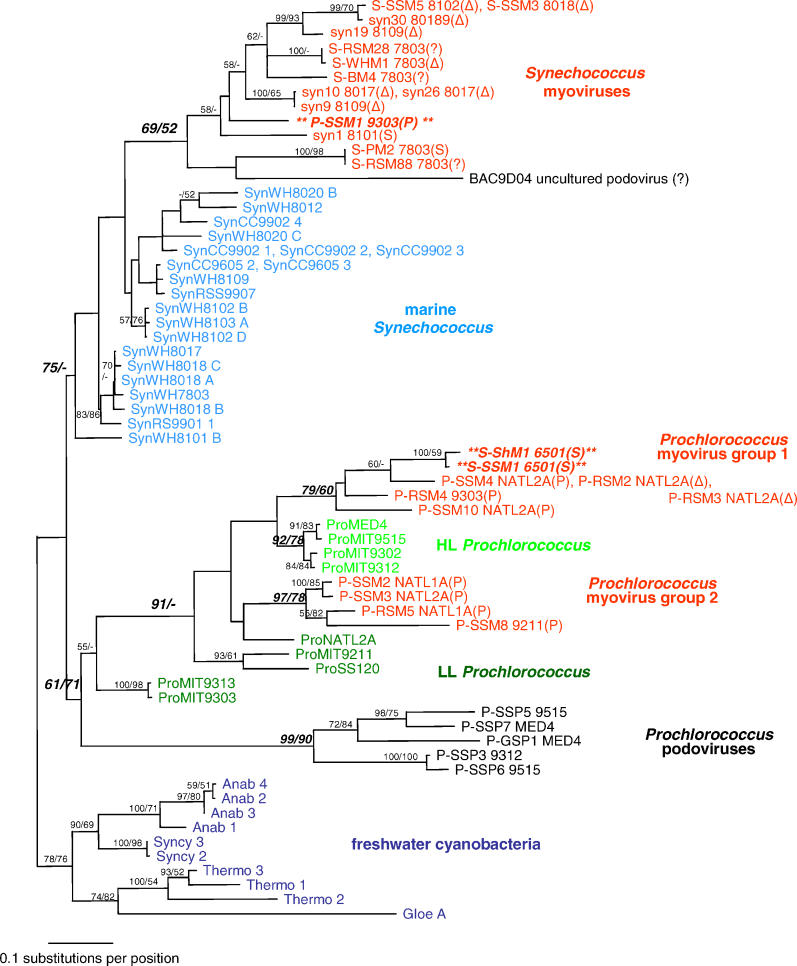
Phylogenetic Tree of
psbA Gene Sequences from Cultured Cyanobacteria and Cyanophages
Phages are listed by their name, followed by their original host. Phages that are known to infect both
Prochlorococcus and
Synechococcus hosts are indicated with a “Δ”; those that infect only one genus are labeled either P (infect only
Prochlorococcus hosts) or S (infect only
Synechococcus hosts), while those that are unknown are designated with a “?”. Phages shown in italics and bracketed with “**” were isolated on hosts that do not belong to the same cluster and are thus exceptions to the general clustering pattern (see text). Taxa are color coded according to the following biological groupings: myoviruses (red), podoviruses (black), marine
Synechococcus hosts (light blue), marine
Prochlorococcus hosts (dark green, LL; light green, HL), freshwater cyanobacteria (dark blue). The tree topology was estimated by LogDet analysis of 1st and 2nd codon positions. Sequences where intragenic recombination was detected using other methods (see
Materials and Methods) were not included in these phylogenetic analyses. Branch lengths were estimated by maximum likelihood under a model with nonstationary nucleotide frequencies. Numbers at the nodes represent neighbor-joining bootstrapping and maximum likelihood puzzling support. Anab,
Anabaena; Gloe, Gleobacter; HL, high-light adapted; LL, low-light adapted; Syncy,
Synechocystis; Thermo,
Thermosynechococcus.